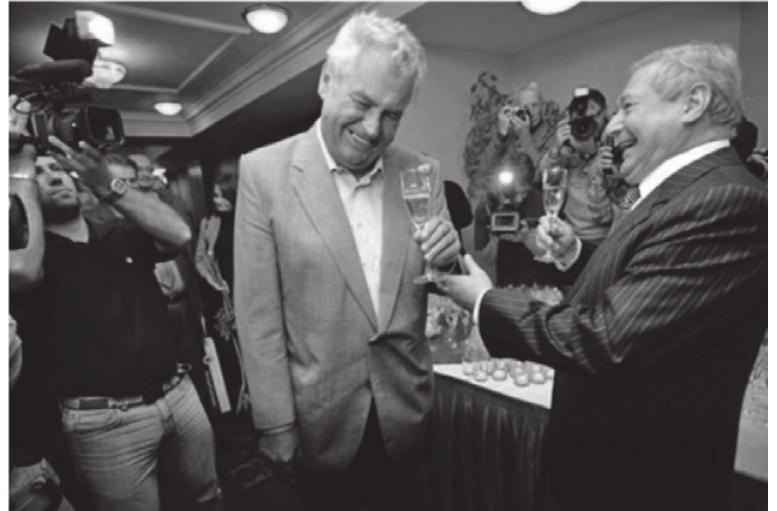
Fig. 6. Miloš Zeman, Lidovky.cz , 22. 1.